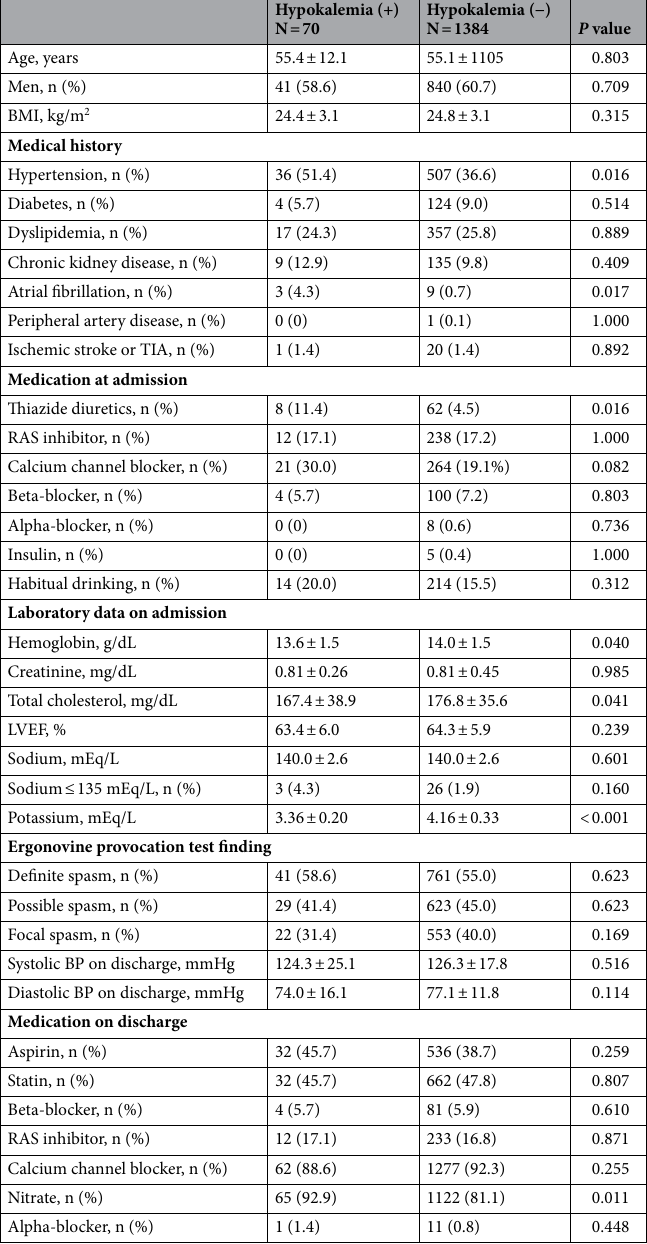
Table 1. Baseline characteristics of the patients with vasospastic angina. BMI body mass index, TIA transient ischemic attack, RAS renin-angiotensin system, LVEF left ventricle ejection fraction, CKD chronic kidney disease, BP blood